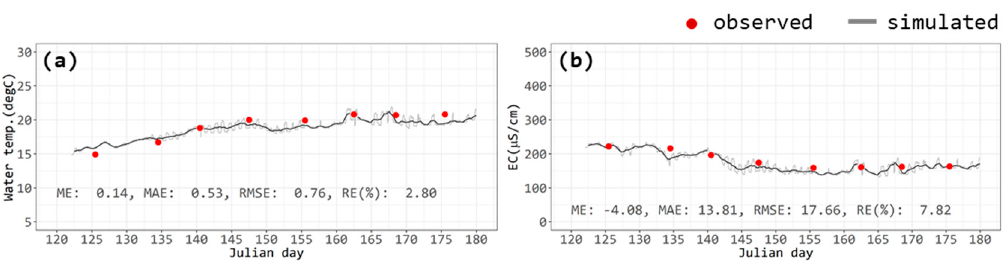
Figure 5. Comparison of temporal variations of ( a ) observed and simulated water temperature and ( b ) electrical conductivity at the outflow of Paldang Dam.